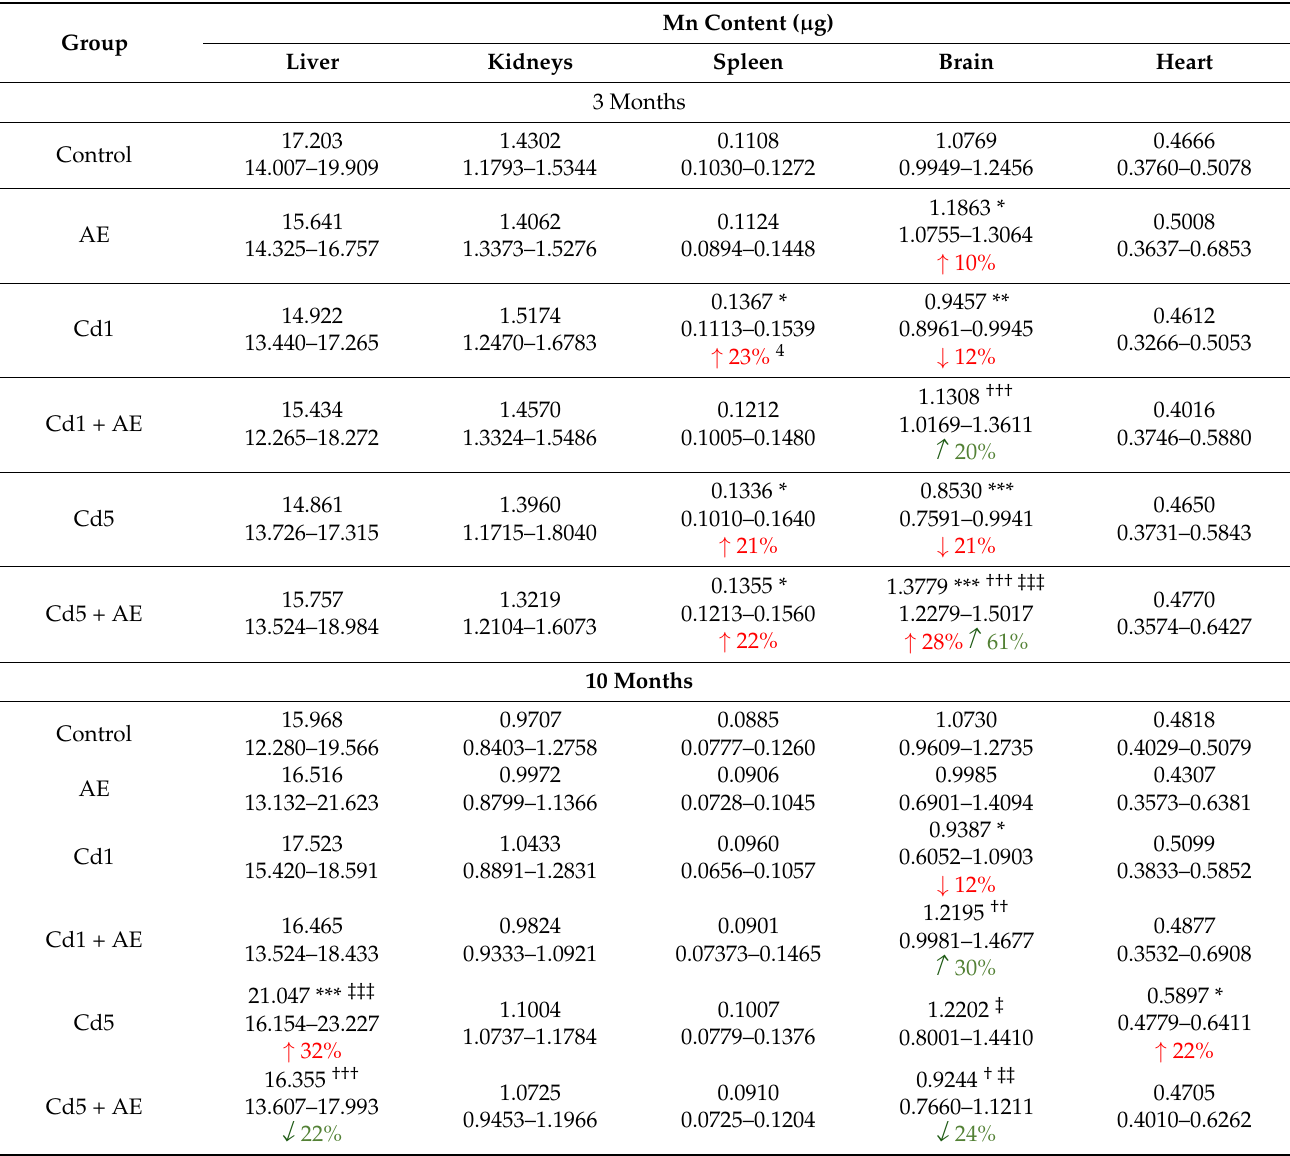
Table 3. The total content of Mn in the internal organs in particular experimental groups after 3 and 10 months of the study 3